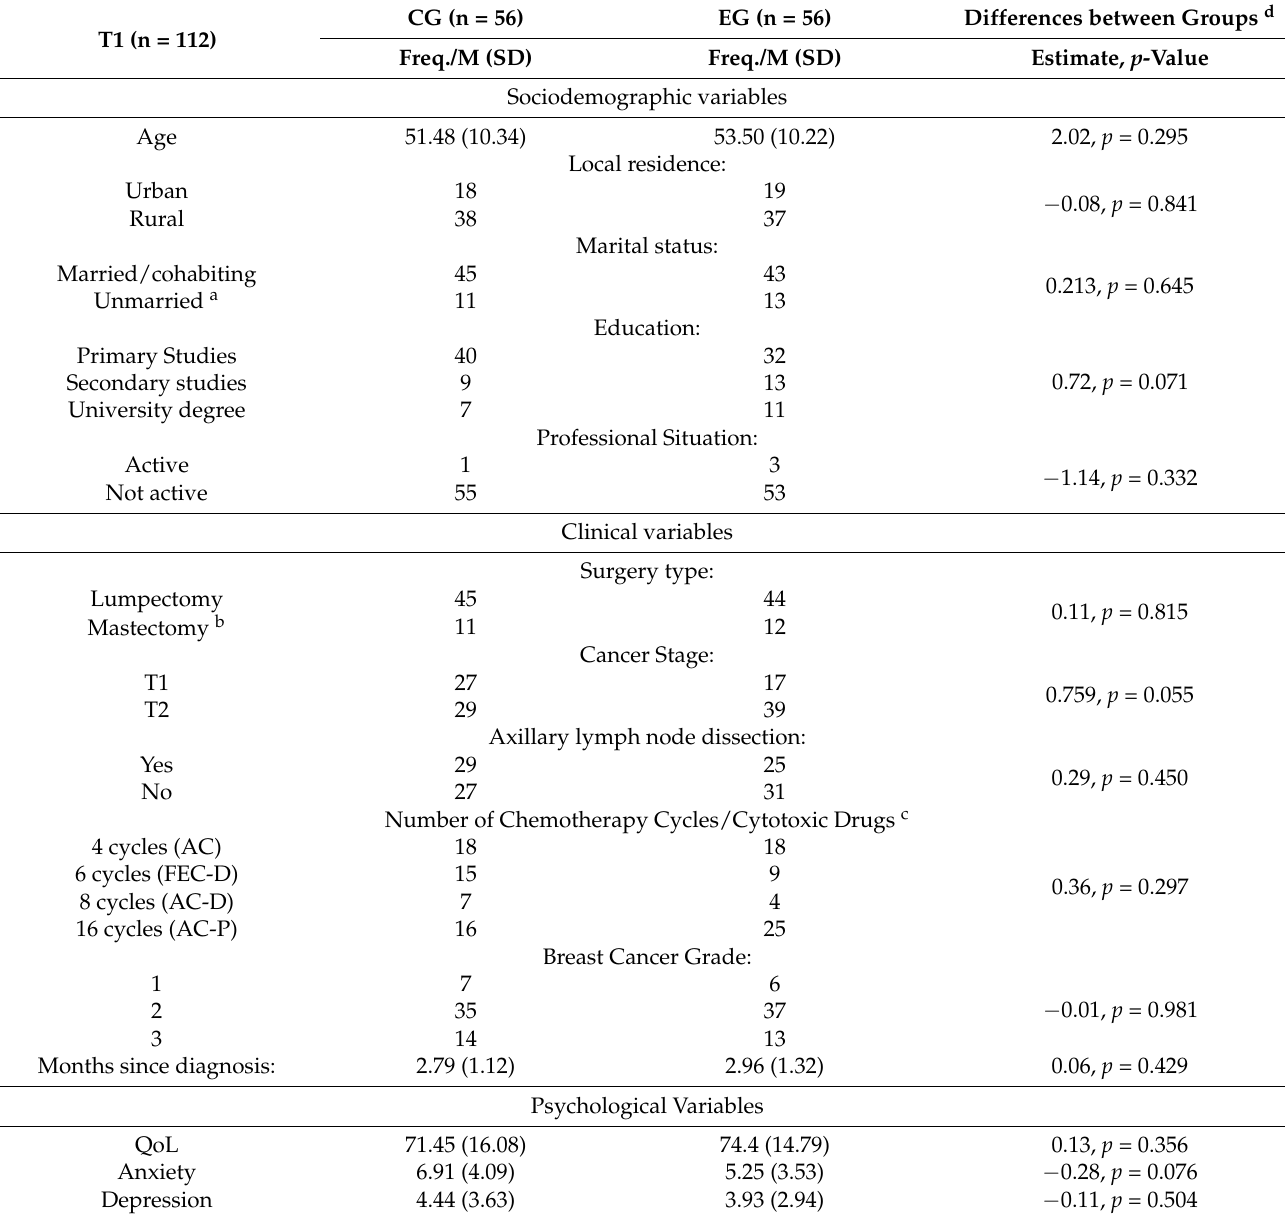
Table 1. Socio-demographic and clinical characteristics and balance per